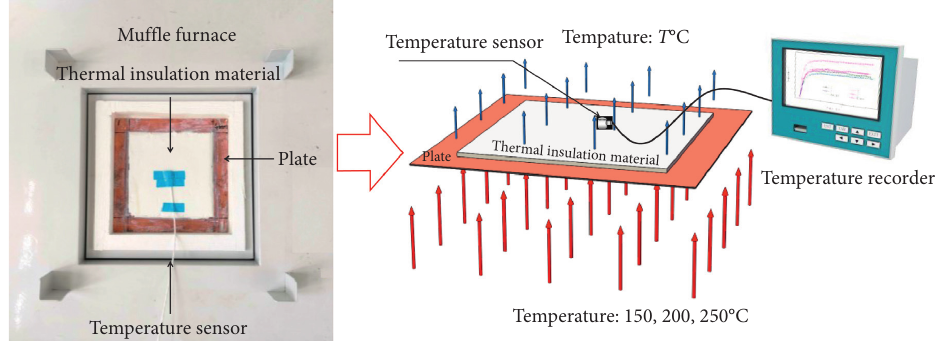
Figure 7: Insulation performance test.